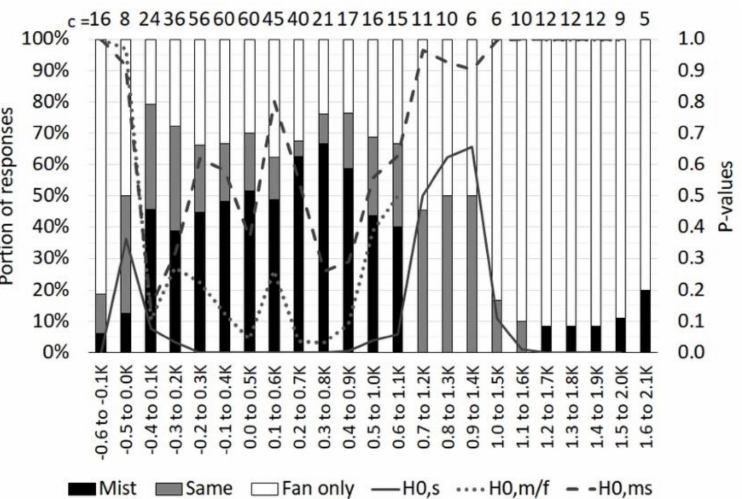
Figure 8. Proportion of responses on which air stream felt cooler in a rolling evaluation of 0.5 K bin width steps. Responses from the second experiment